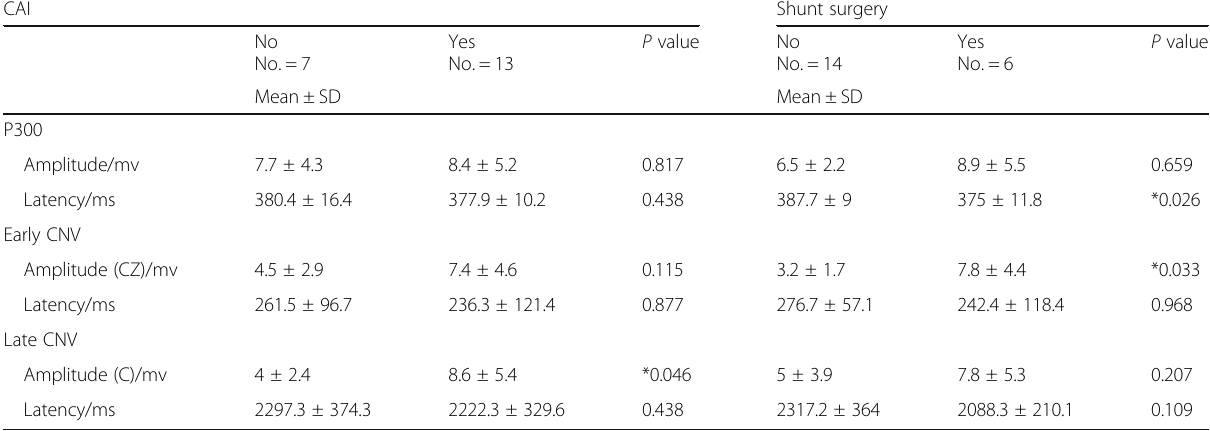
Table 4 Comparison between results of NP Tests in patients of group I as regards different lines of treatment